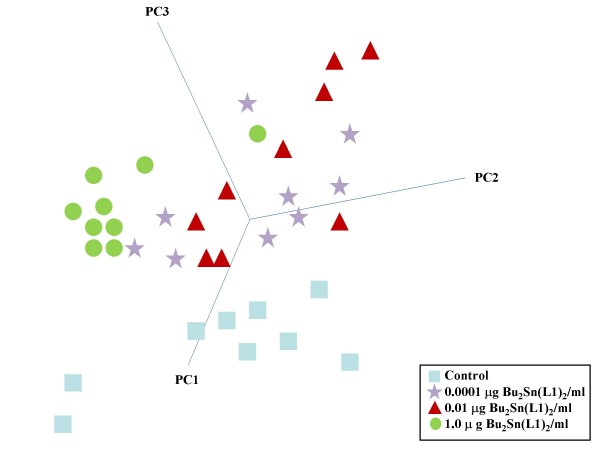
3-D scores plot on PCs selected to demonstrate best segregation of MCF-7 cell IR spectra derived following 24-h exposure to Bu2Sn(L1)2, as indicated. IR spectra were collected using ATR-FTIR spectroscopy. Each spectrum was expressed in terms of chosen PCs using Pirouette software and rotated to identify segregation of different clusters. Each symbol represents a single spectrum as a single point in "hyperspace". The 3-D scores plot represents the segregation of cell populations following different exposures (i.e., vehicle control vs. 0.0001 μg/ml vs. 0.01 μg/ml vs. 1.0 μg/ml organotin(IV) carboxylate) on PC1, PC2 and PC3.